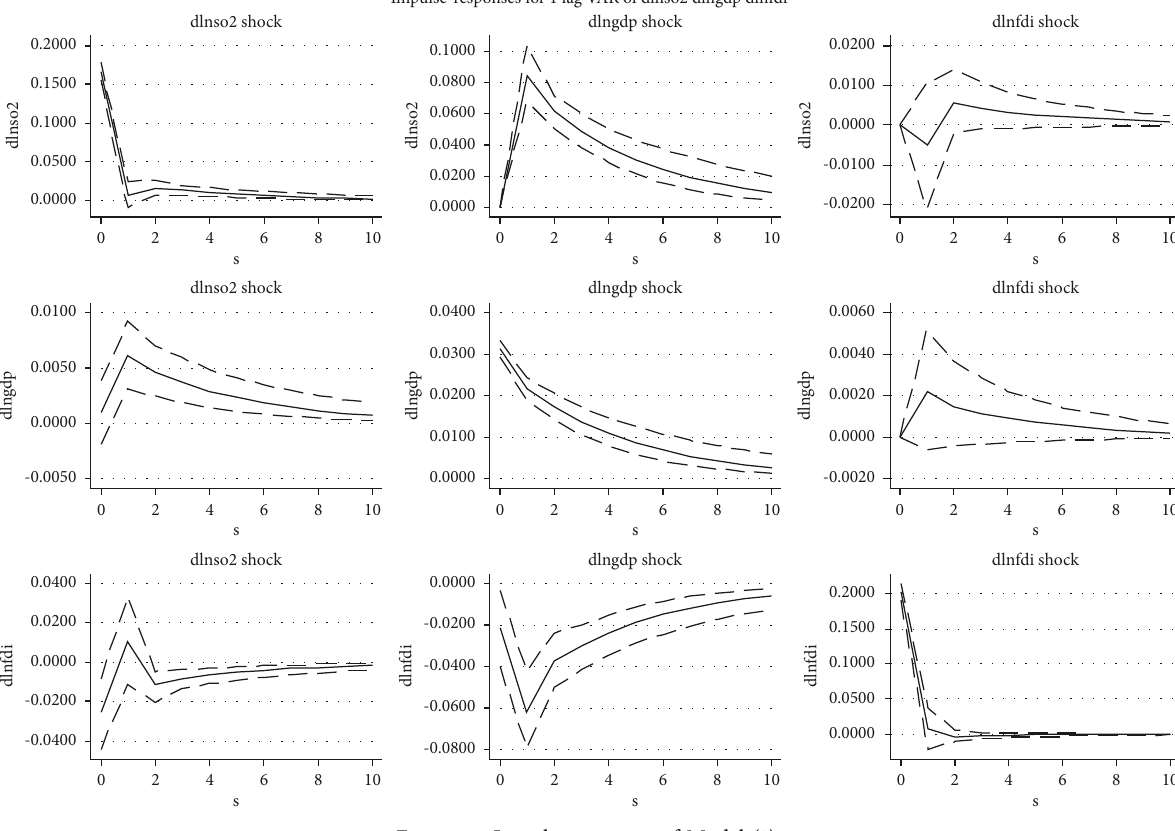
Figure 5: Impulse response of Model